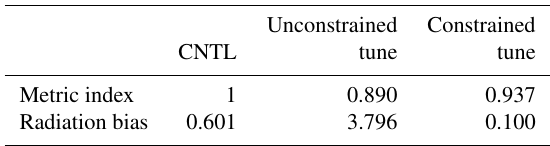
Table 3. Synthesized performance metric index and radiation bias in the CNTL run and the optimal model run with unconstrained and constrained